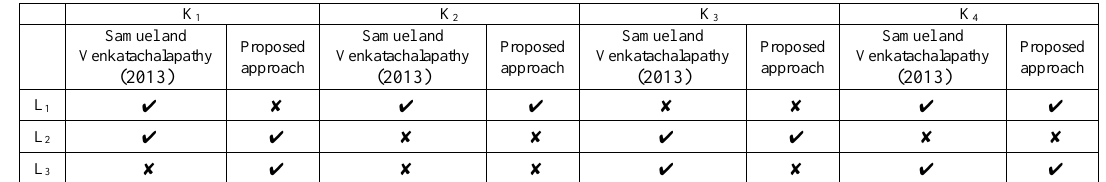
Table 8. Comparison for allocation (Example 2)